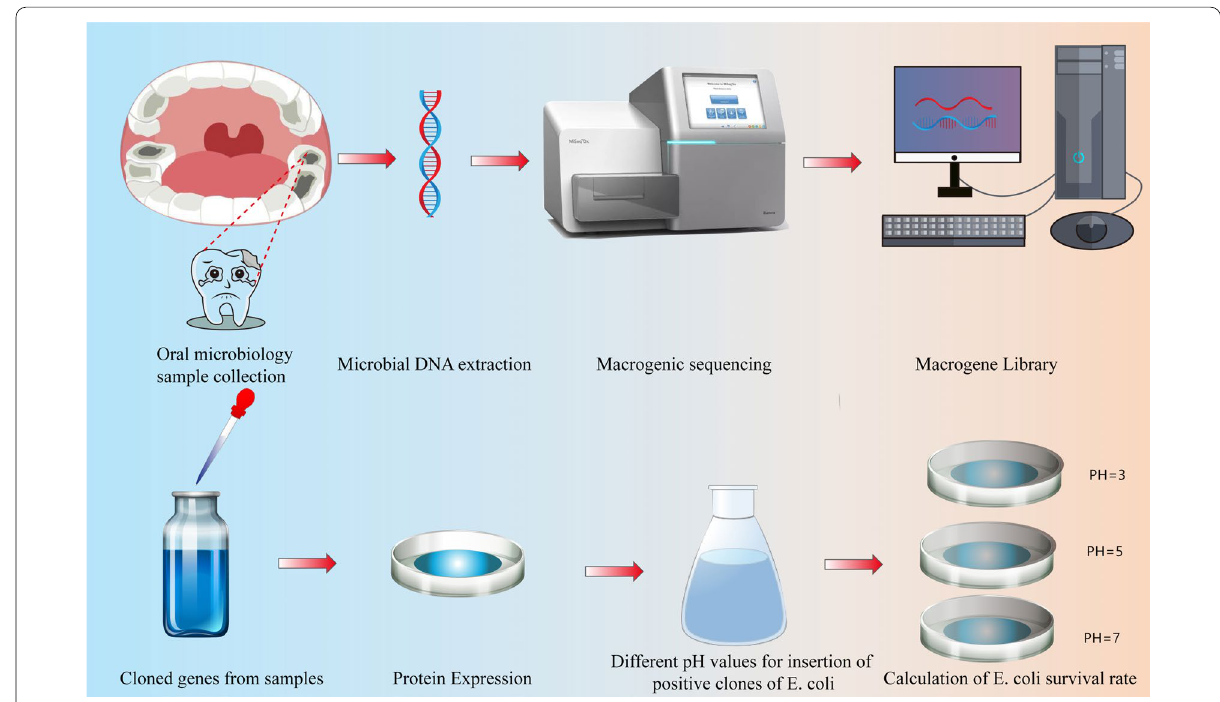
Fig. 1 Experimental Mind